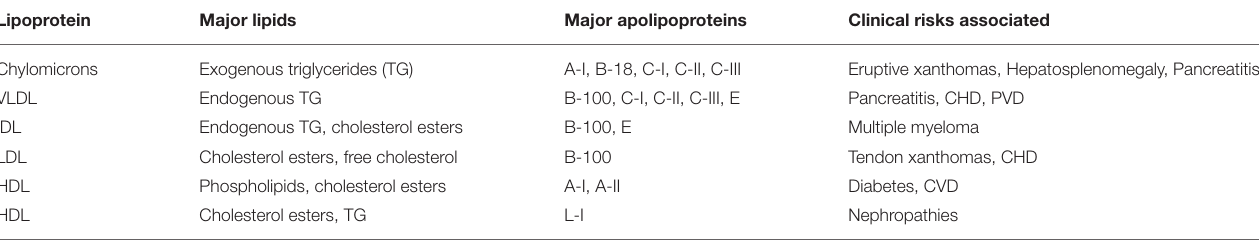
TABLE 1 | The different lipoproteins expressed and their major genotypic risks associated with concordant disease conditions.